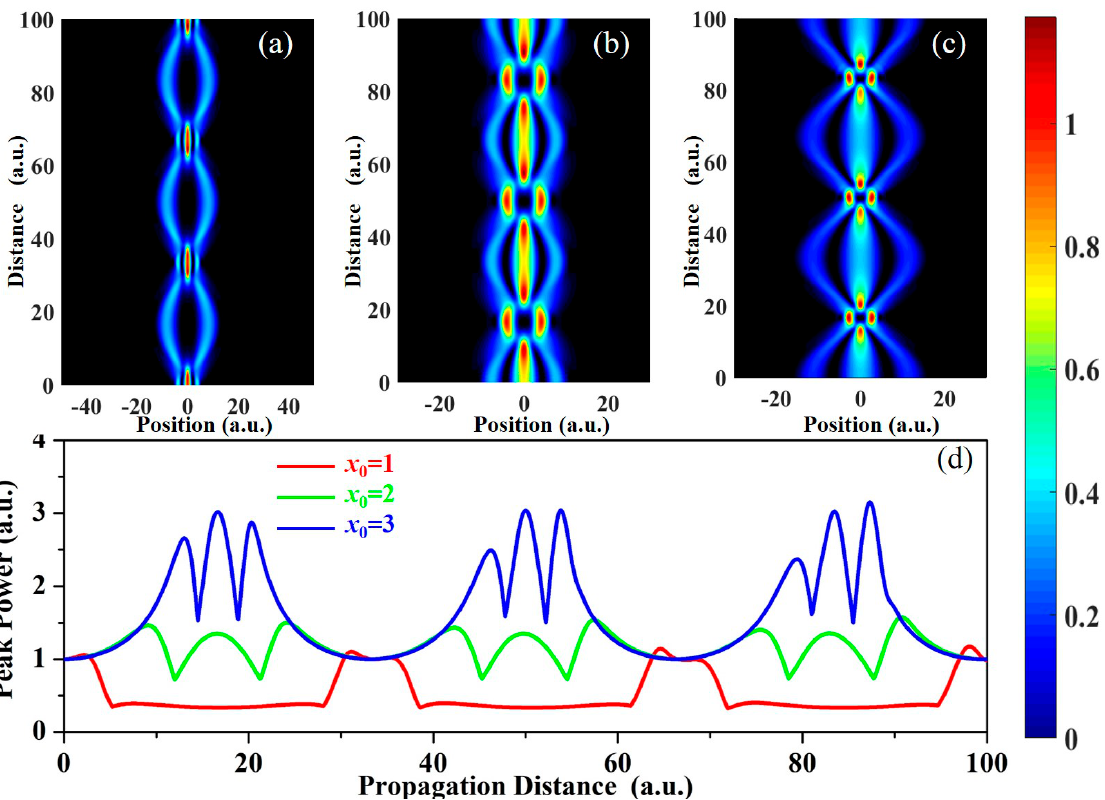
Figure 4. When φ 0 = 2 π /3, P 0 = 10, ω 0 = 0.03, the spatial evolution of Cos − Gaussian pulses with three different initial widths: ( a ) x 0 = 1, ( b ) x 0 = 2, and ( c ) x 0 = 3; ( d ) the peak power evolution of the breathing solitons: x 0 = 1 (red line), x 0 = 2 (green line), and x 0 = 3 (blue line).